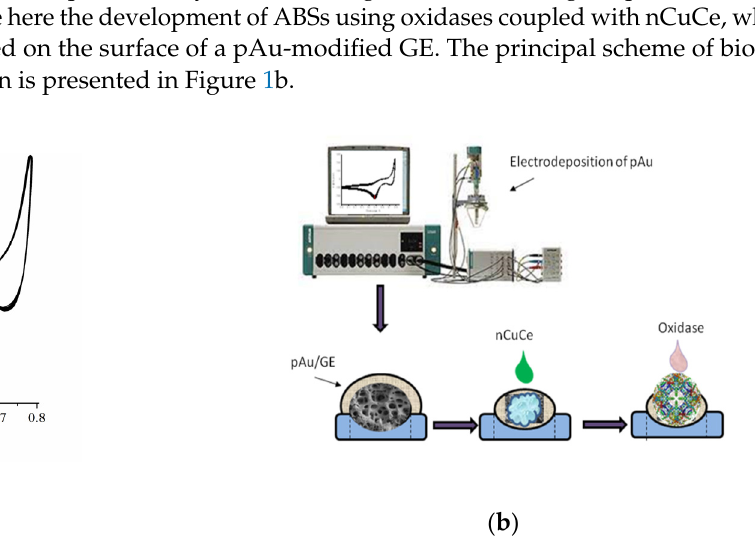
Figure 1. ( a ) CV profiles during 25 cycles of film electrodeposition with a scan rate 50 mV s − 1 vs. Ag/AgCl; ( b ) Scheme of the working electrode preparation.